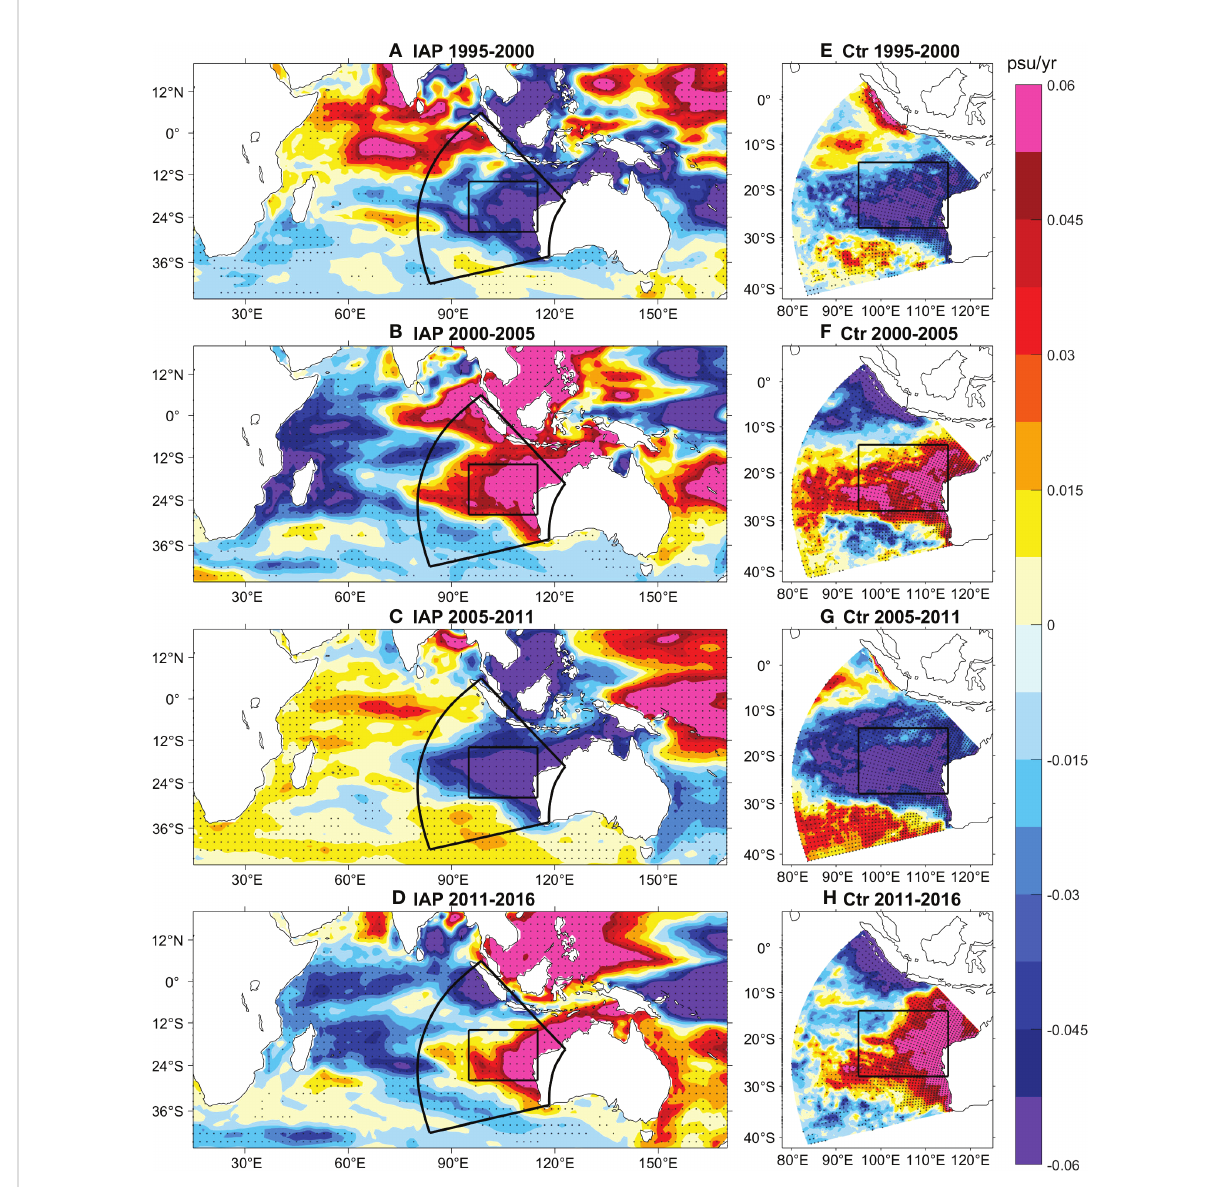
FIGURE 3 Linear trend maps of SSS for the periods of (A) 1995-2000, (B) 2000-2005, (C) 2005-2011, and (D) 2011-2016 derived from IAP. (E – H) As in (A – D) , but for derived from Ctr, respectively. Stippling indicates signi fi cant trends at 90% con fi dence level based on a Mann-Kendall test. Black lines denote the model domain (sector shape) and the SEIO region